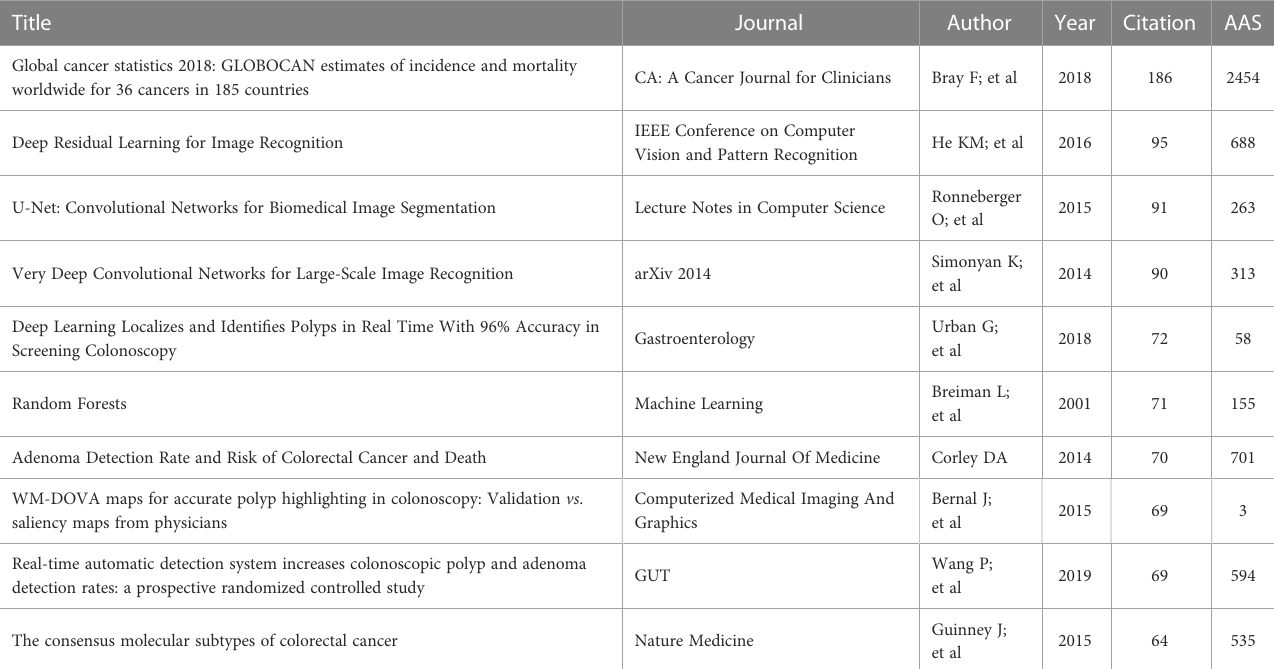
TABLE 6 Top 10 references with the most